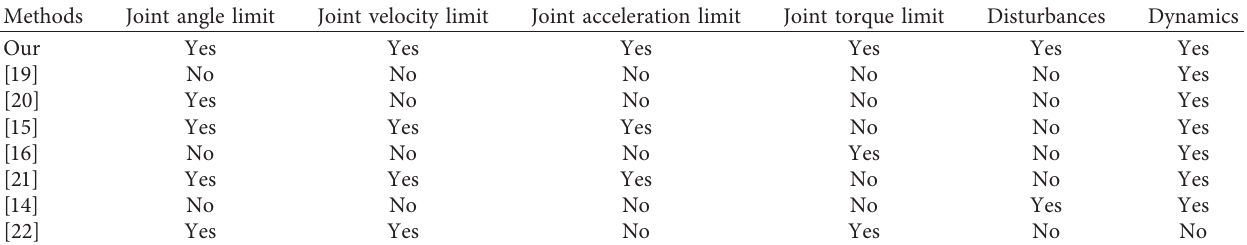
Table 1: Comparison between this paper and the existing QP-based torque